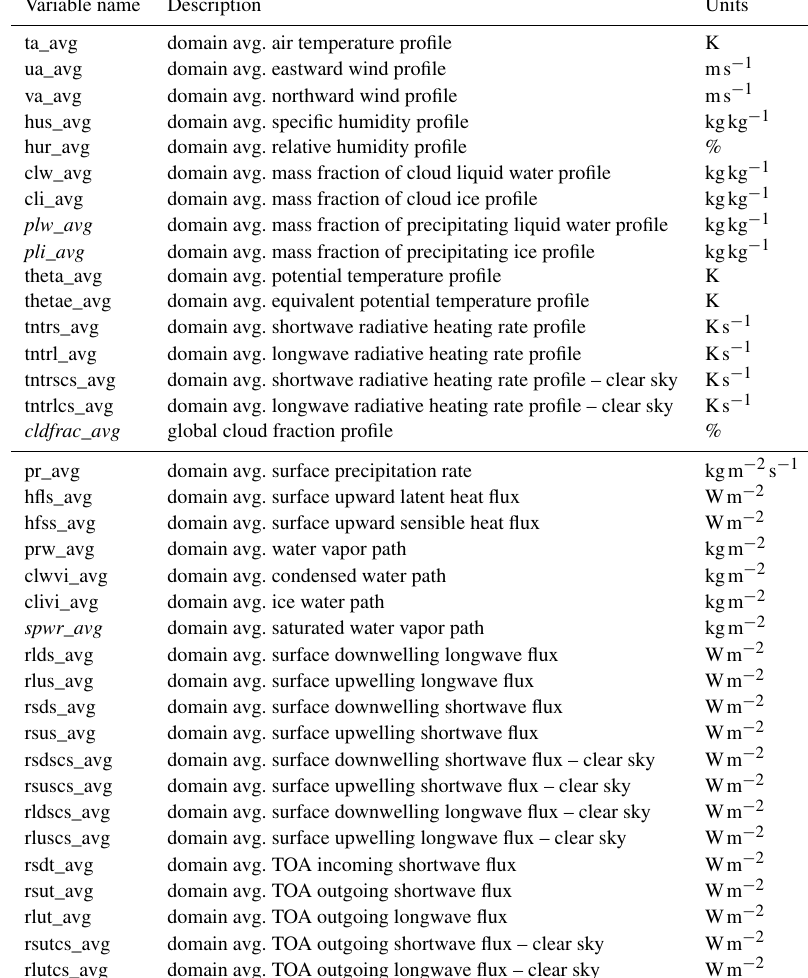
Table 4. The 1-D hourly-averaged variables ( z,t ) or ( t ). TOA indicates the top of